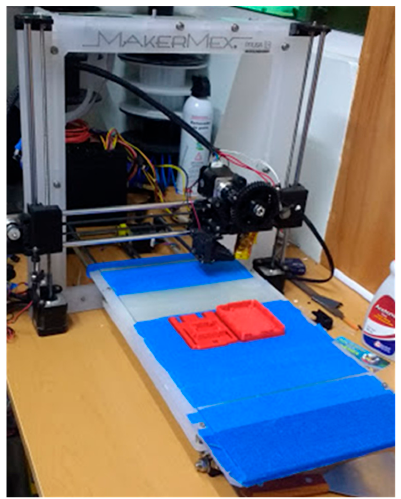
Figure 2. Prusa ® 3D printer. Table 2. The 3D printing parameters.